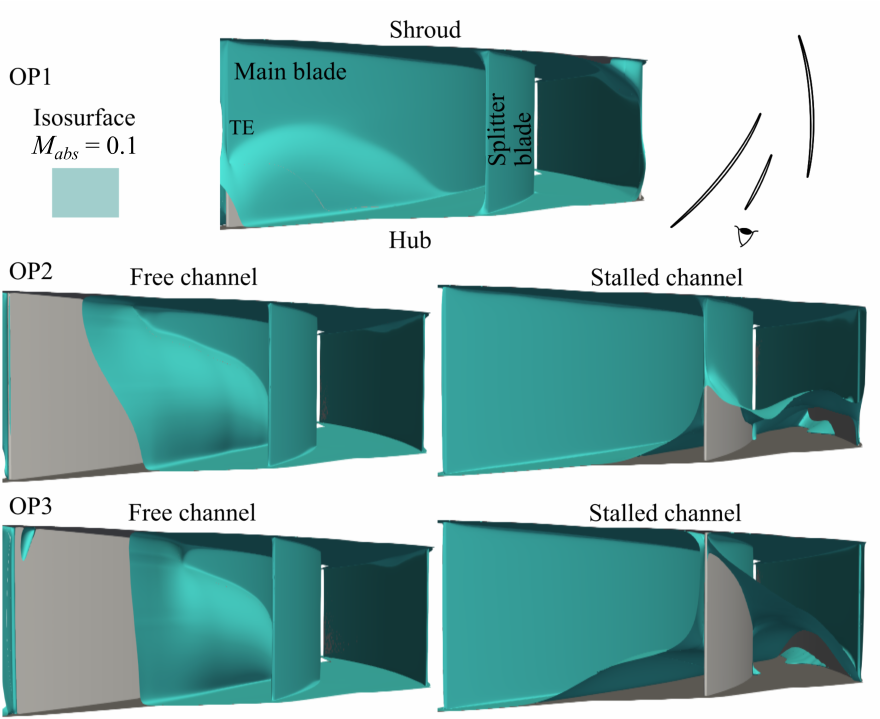
Figure 11. Change in low Mach number zones with decreasing mass flow rate: isosurface M abs = 0.1 viewed from the diffuser